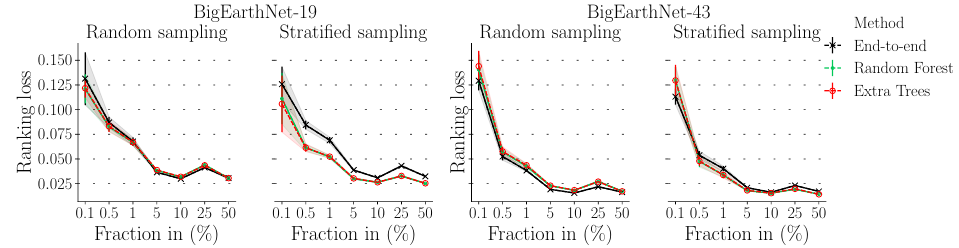
Figure 9. Comparison between different learning methods in terms of ranking loss when evaluated on different fractions of labeled examples from the BigEarthNet-19 and BigEarthNet-43 datasets,. The results are shown as learning curves depicting µ ± σ for ranking loss across five repeats. The y-axis is shared across the